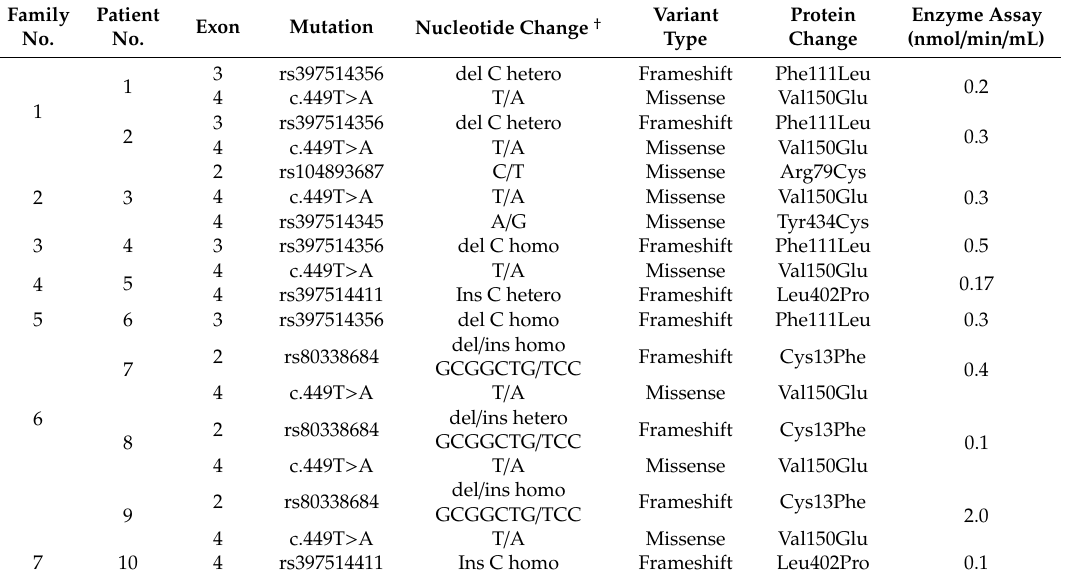
Table 3. BTD gene genotyping and enzyme activity measurement in biotinidase-deficient patients. Family No.